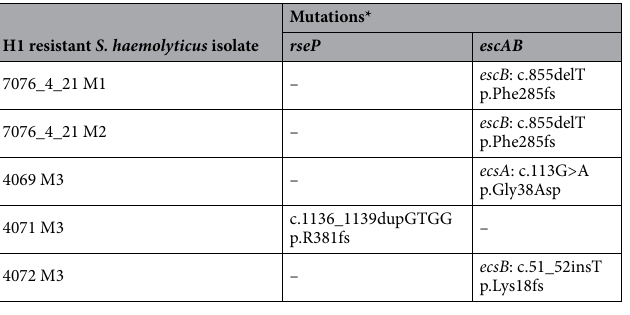
Table 3. Whole genome sequencing of selected H1 resistant mutants. *: Intact gene, c: Coding DNA, p: Protein, del: deletion, fs: frameshift, >: Substitution, ins: Insertion, dup: